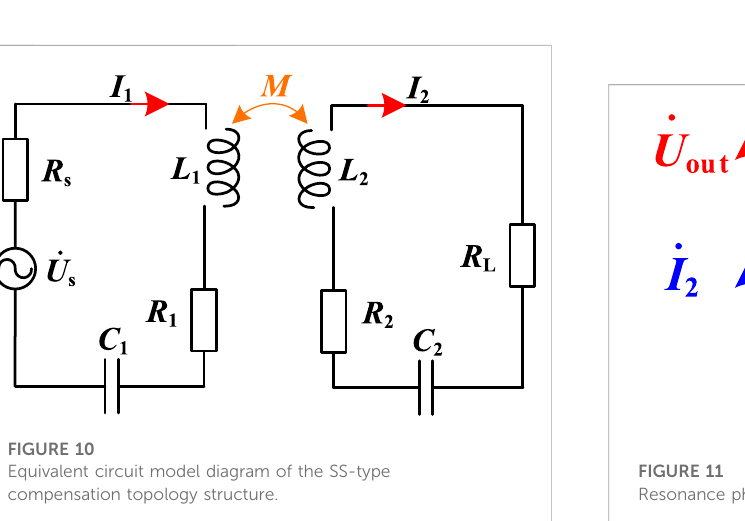
FIGURE 10 Equivalent circuit model diagram of the SS-type compensation topology structure.